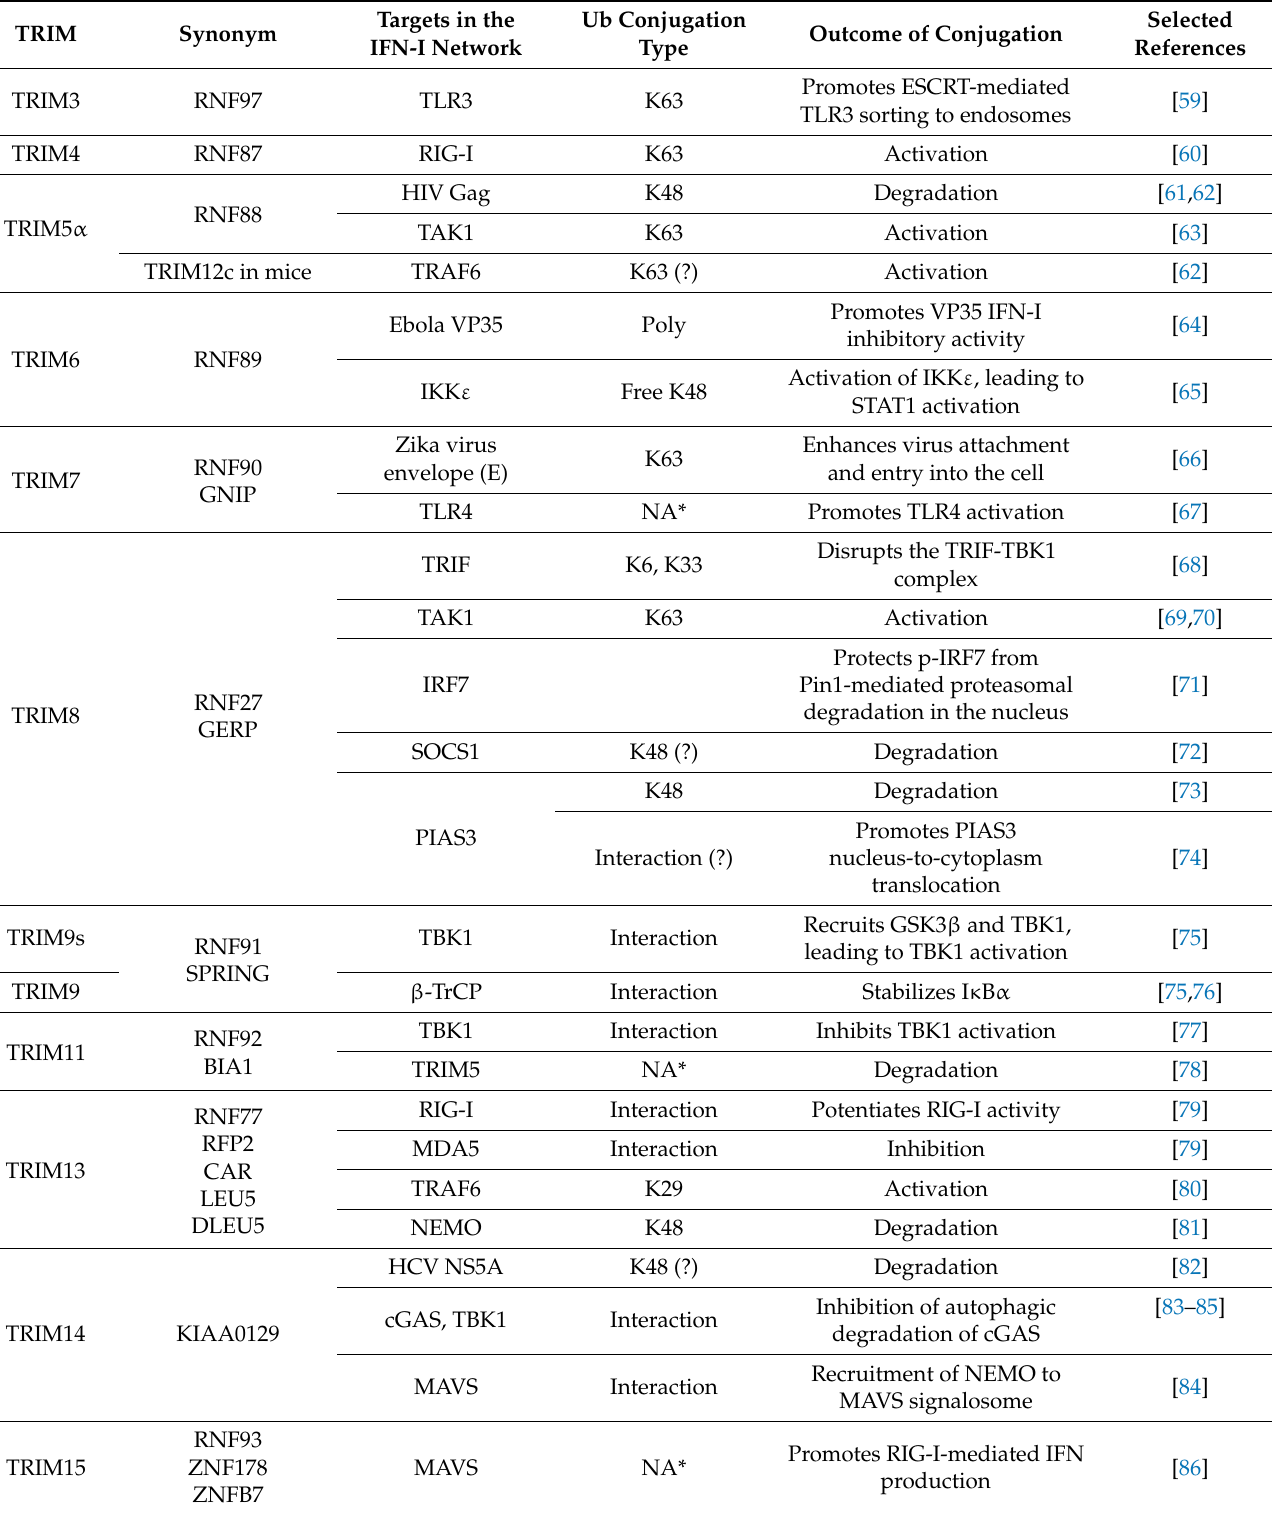
Table 1. TRIMs in the regulation of Interferon (IFN)-I-mediated innate immune